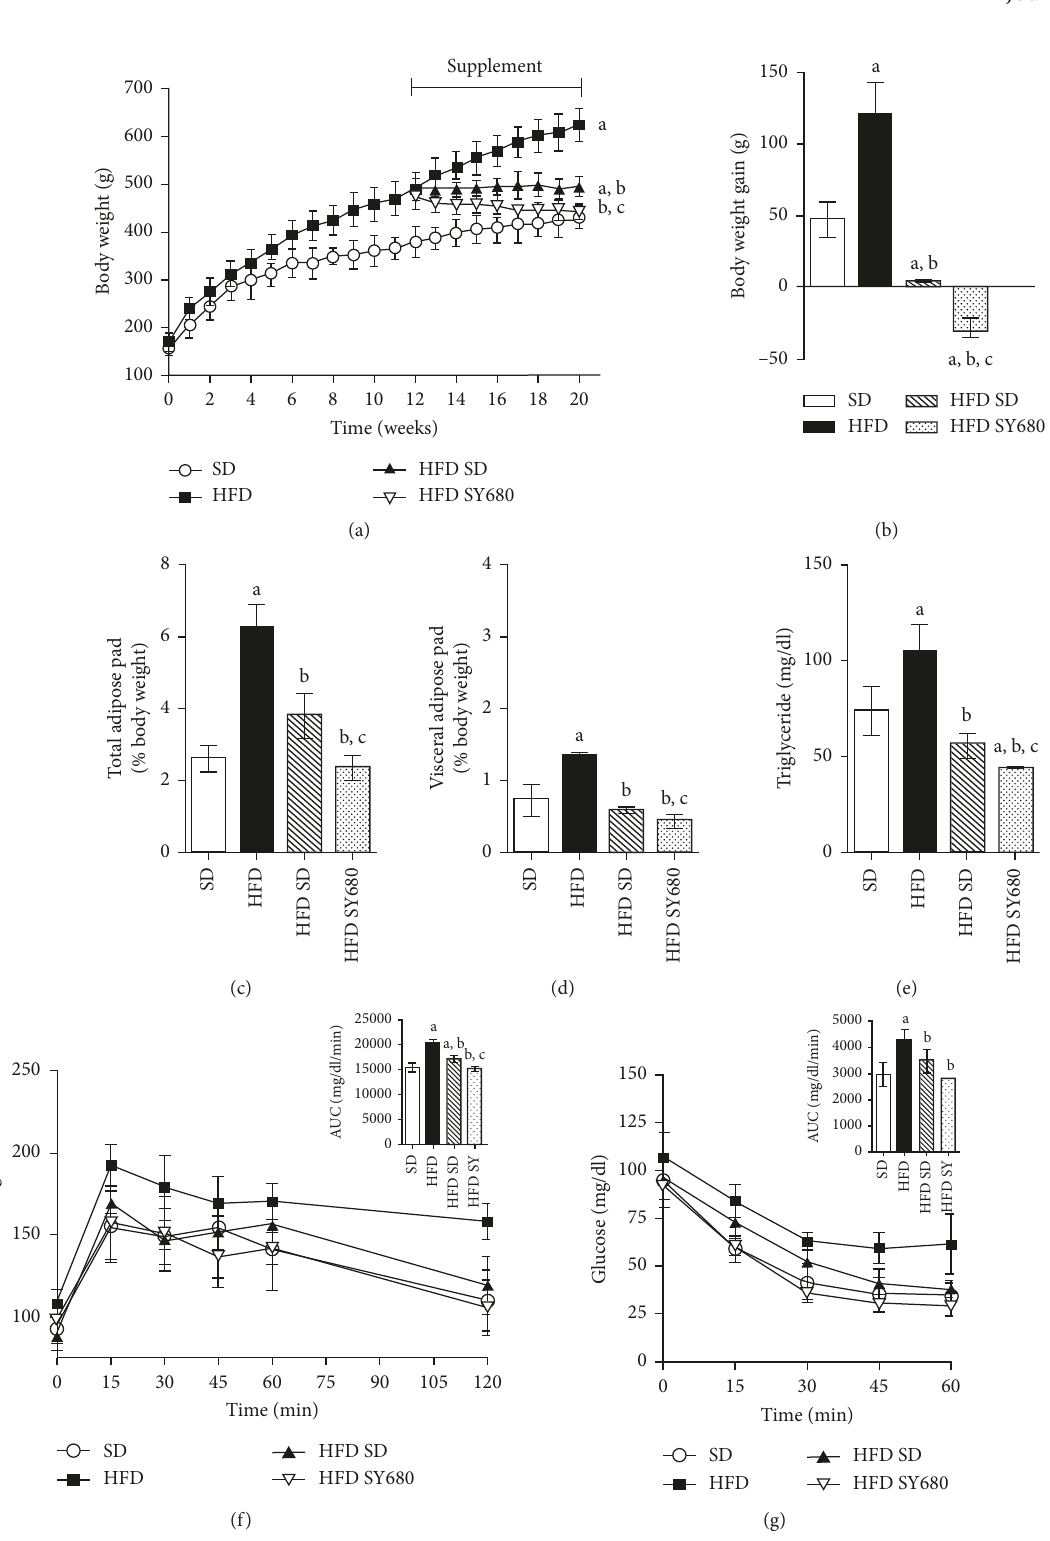
Figure 7: Effects of yacon supplement and the reversion to a SD chow on HFD-induced metabolic disease. (a) Body weight. (b) Body weight gain. (c) Total fat weight. (d) Visceral fat pad weight. (e) Fasting triglyceride concentrations. (f) Time course of glycemia in response to oral glucose overload (2g/kg body weight) at 8 weeks (insert: area under the curve of blood glucose following glucose overload). (g) Time course of glycemia following a single intraperitoneal (i.p.) injection of insulin (0.75U/kg b. w.) (insert: area under the curve of blood glucose following insulin injection). Data are mean ± standard deviation ( n � 6/group). a p < 0 . 05 vs. SD, b p < 0 . 05 vs. HFD, c p < 0 . 05 vs. HFD SD. SD: standard-diet-fed rats; HFD: high-fat-diet-fed rats; HFD SD: high-fat-diet-fed rats reversed to a SD chow; HFD SY680: high-fat-diet-fed rats reversed to a SD chow and supplemented with yacon flour (680 mg FOS/kg